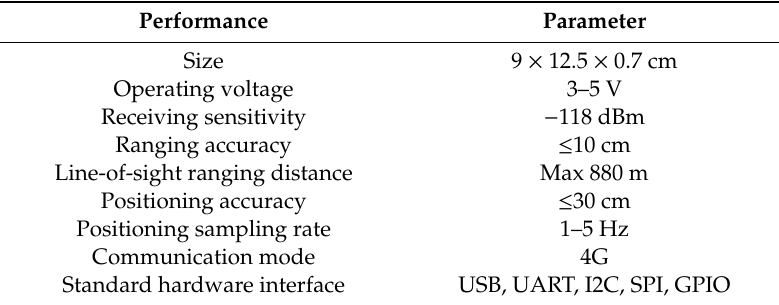
Table 2. Performance of UWB anchor and tag two-in-one equipment device.